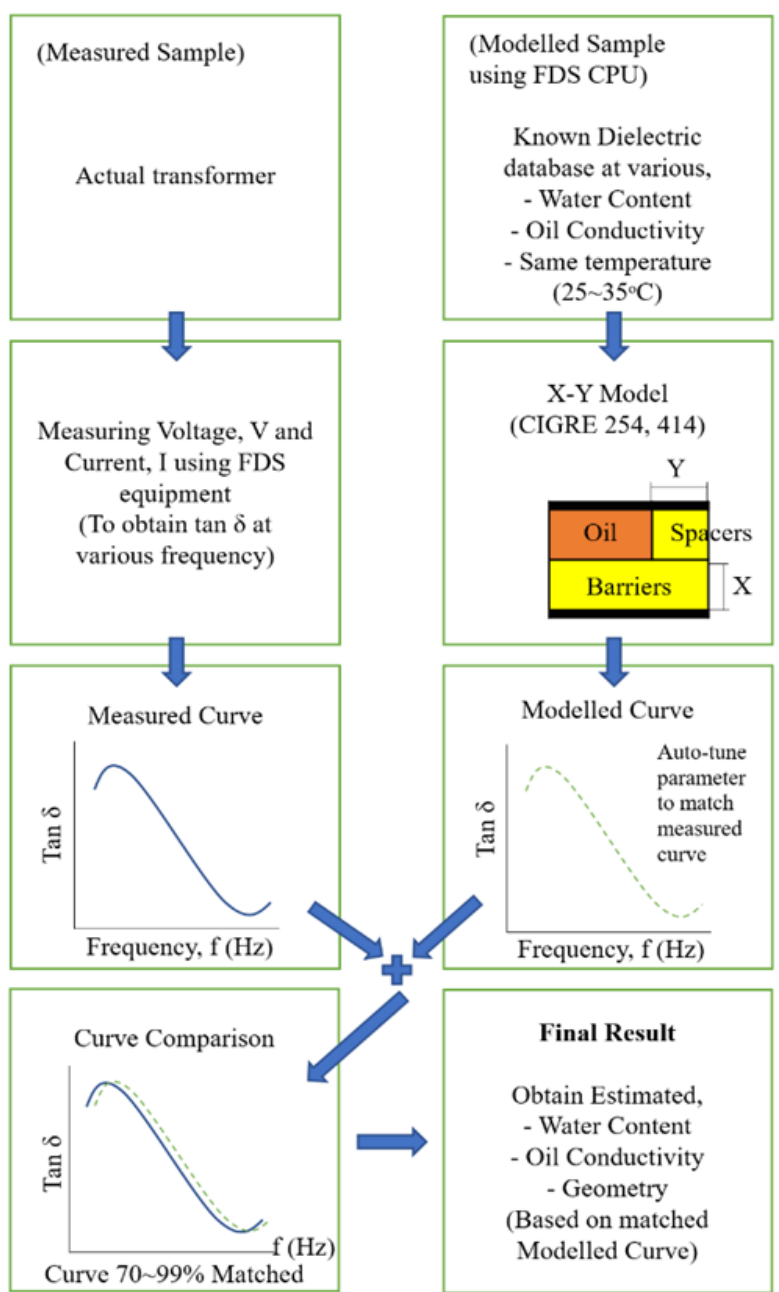
Figure 9. FDS measurement procedure. Theoretically, tan δ is inversely proportional to frequencies. This phenomenon is significantly more apparent in higher and lower frequencies due to the fact that higher frequencies cause the polarization changes process to happen very fast in the capacitors; thus, it acts like a short circuit (lower tan δ ), whereas in lower frequencies, the polarization changes process took so long to complete that it causes the capacitor to act like an open circuit (higher tan δ ). However, distinct curve patterns in lower and higher frequencies can be observed in Figure 10. This can be related to Equation (10), where an increase in dielectric losses, C’, due to moisture in higher‑ and lower‑frequency areas, corresponds to a decrease in charges’ polarization in cellulose insulation, which consequently influences the tan δ curve in both lower and higher frequencies